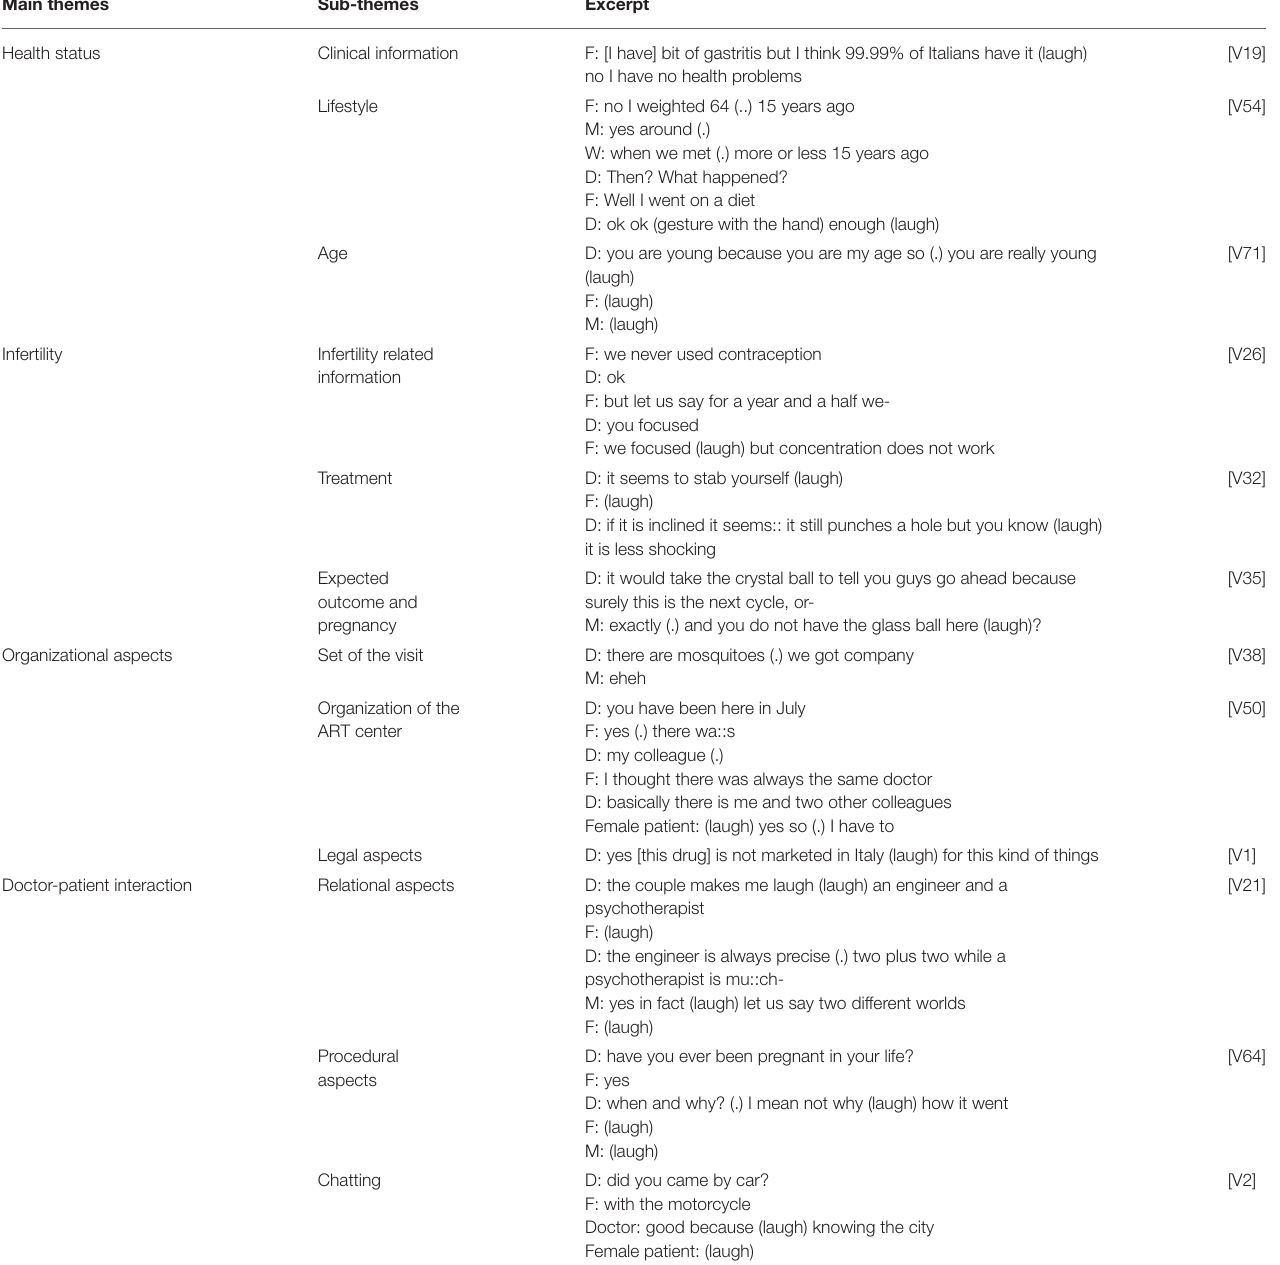
TABLE 3 | Qualitative analysis: themes, sub-themes, and excerpt from ART